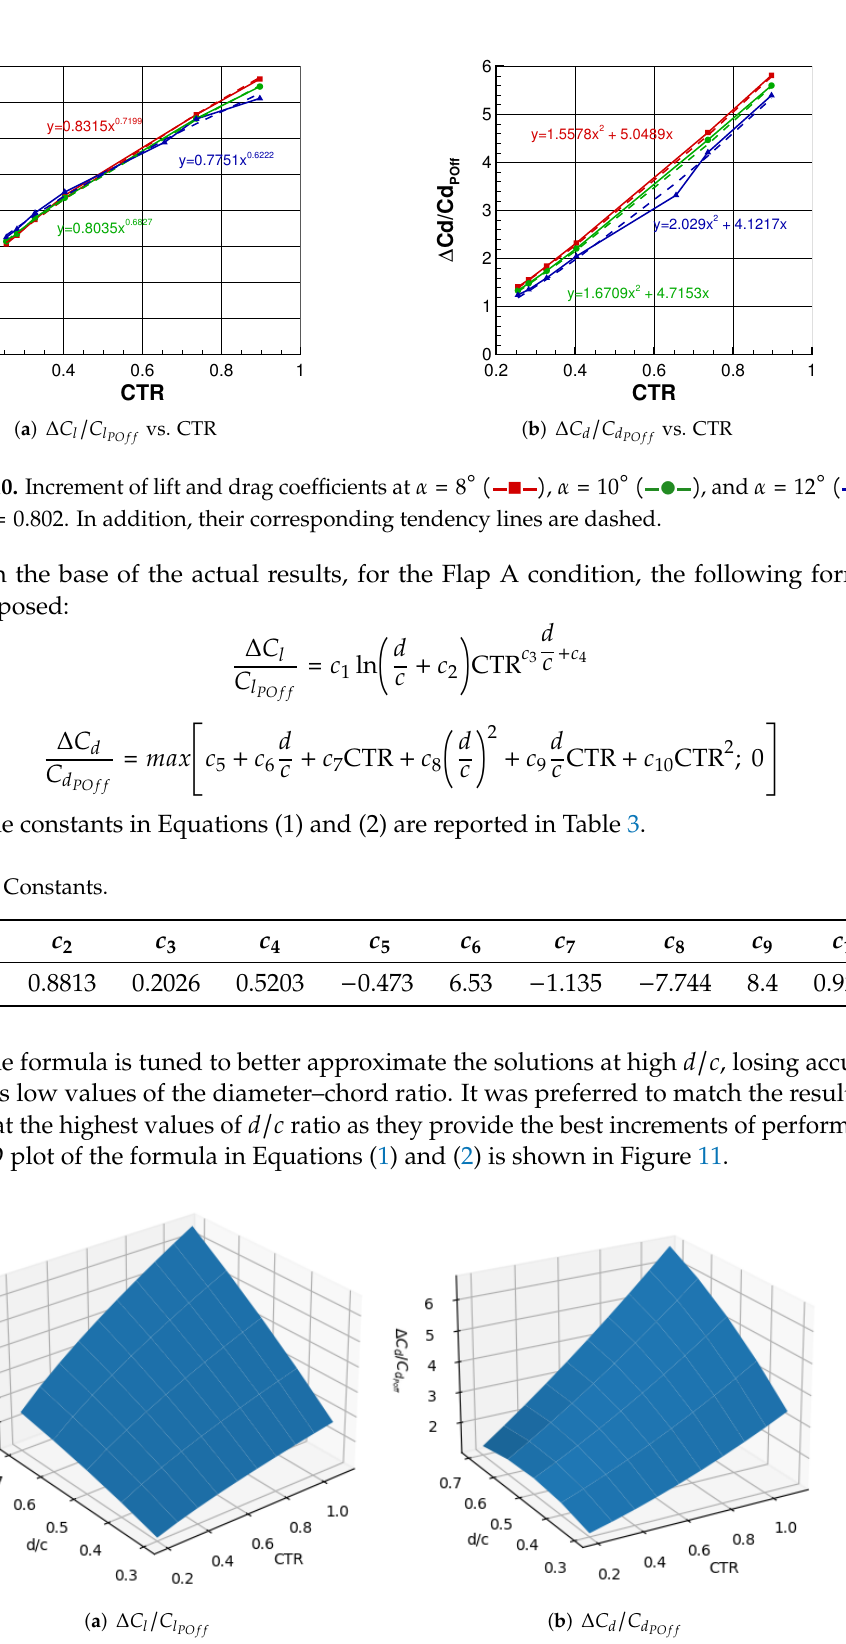
Figure 11. Surface plot of estimated increment of aerodynamic